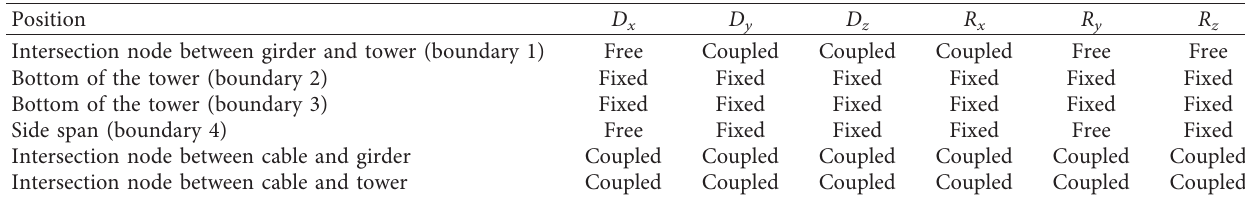
Figure 4: Three-dimensional finite element model. Table 2: Boundary constraint conditions of finite element